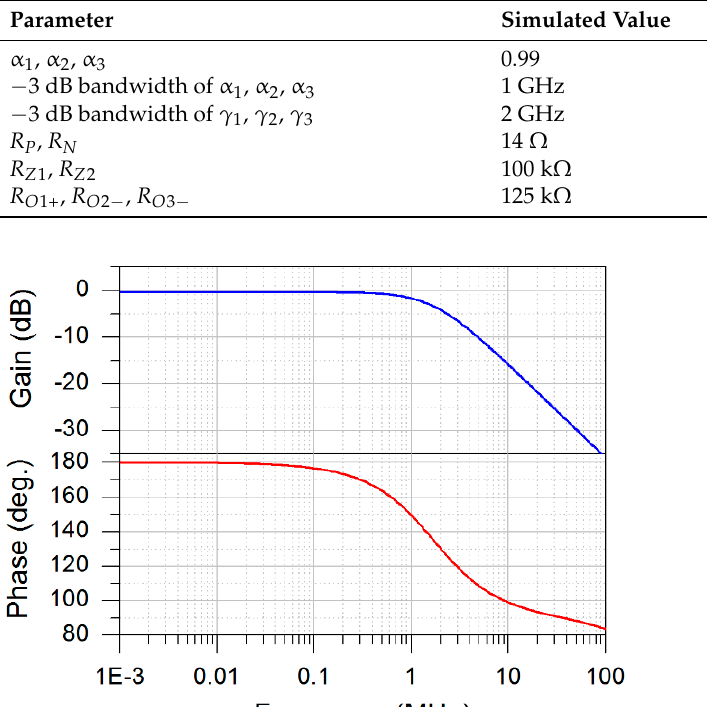
Table 2. Simulated values of non-idealities and parasitic effects of MOCDTA.